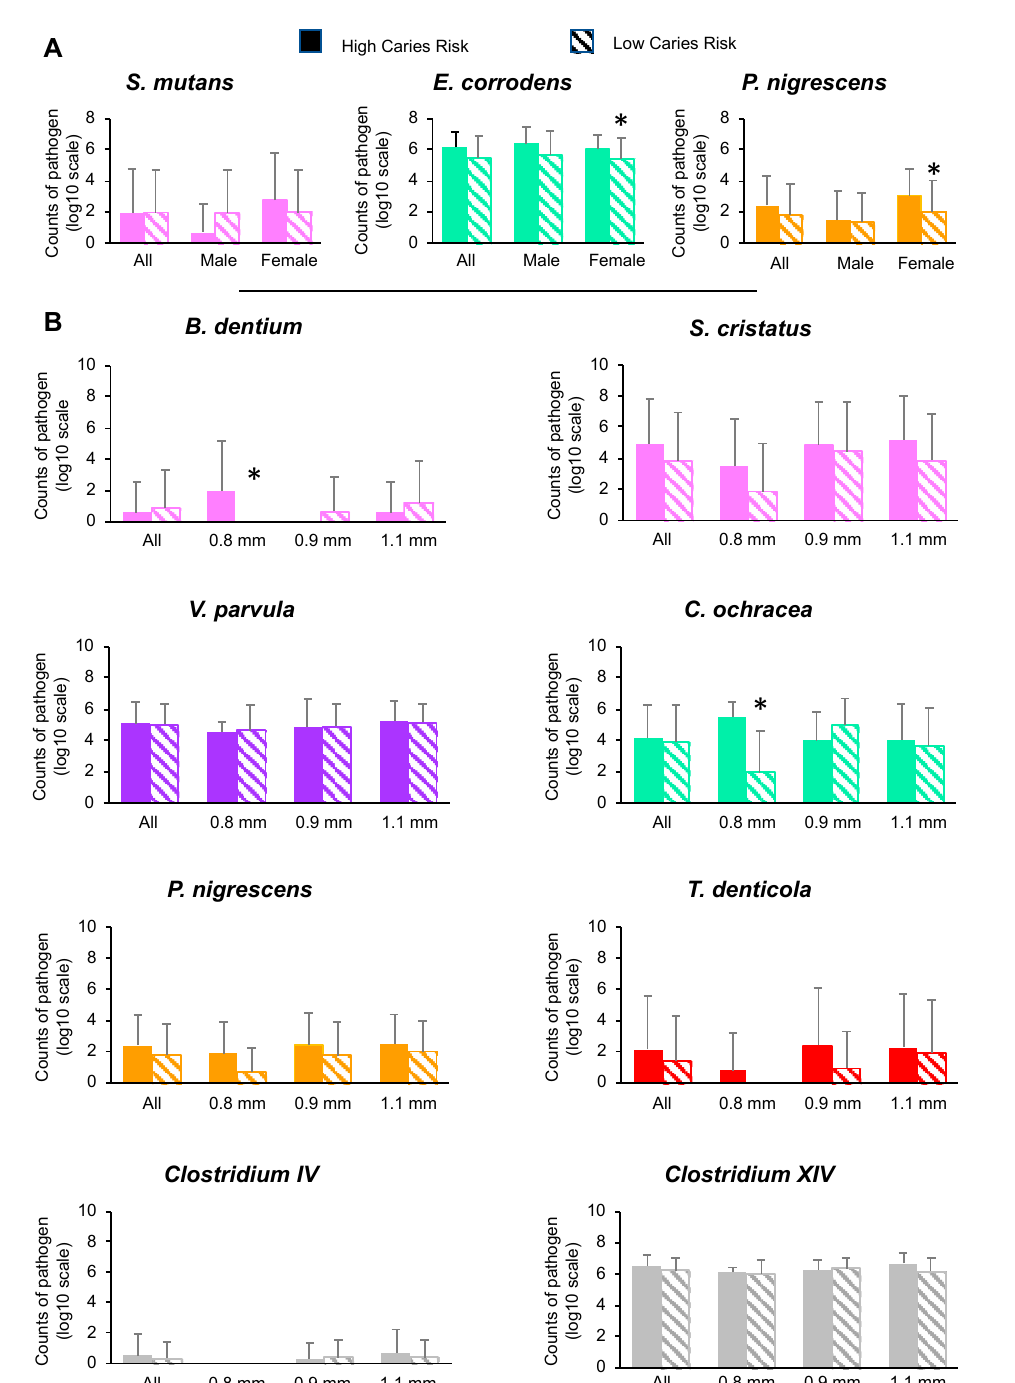
Figure 3. Abundance of bacterial species according to sex and interdental diameter in the low carious risk group and in the high carious risk group. The counts are reported on a log10 scale. Total counts from each pathogen were averaged across sites in each subgroup. Error bars represent standard deviations. This stratified analysis is restricted to those situations where the interaction between caries risk and sex ( A ) or caries risk and IDB size ( B ) on bacterial counts is significant ( p < 0.05) (detailed results not shown). Comparisons: * p < 0.05, by using SUDAAN 7.0 (procedures DESCRIPT and REGRESS) to account for clustering (multiple sites within the subjects). The colors in boxes refer to (i) the colors of the Socransky complexes for the purple, green, yellow, orange, and red colors, (ii) cariogenic bacteria for the pink color and (iii) bacteria from the clostridium group for the gray color. TB: total bacterial load.